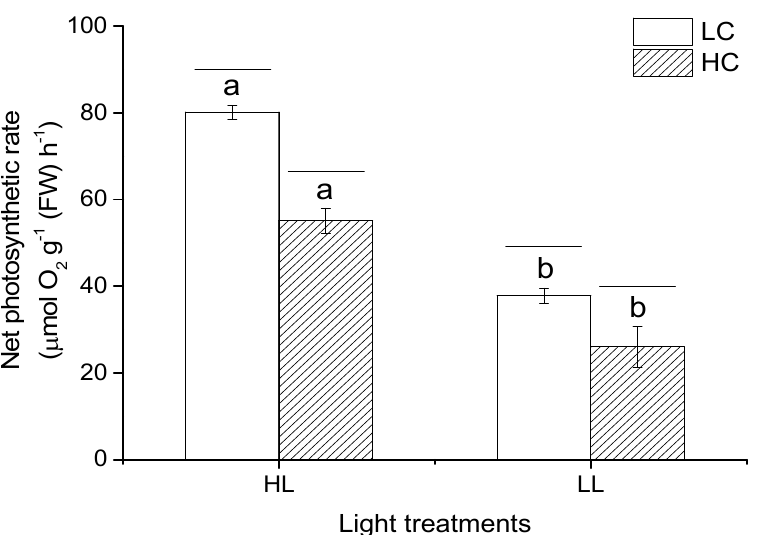
Figure 2. The photosynthesis rate of Porphyra yezoensis under different CO 2 concentrations (400 μ atm, LC; 1000 μ atm, HC) and light treatments. Values show the mean ± SD. Different letters (a and b) represent significant differences ( p < 0.05) at different light treatments under the same CO 2 levels. Horizontal bars represent significant differences ( p < 0.05) between LC and HC under same light treatments.